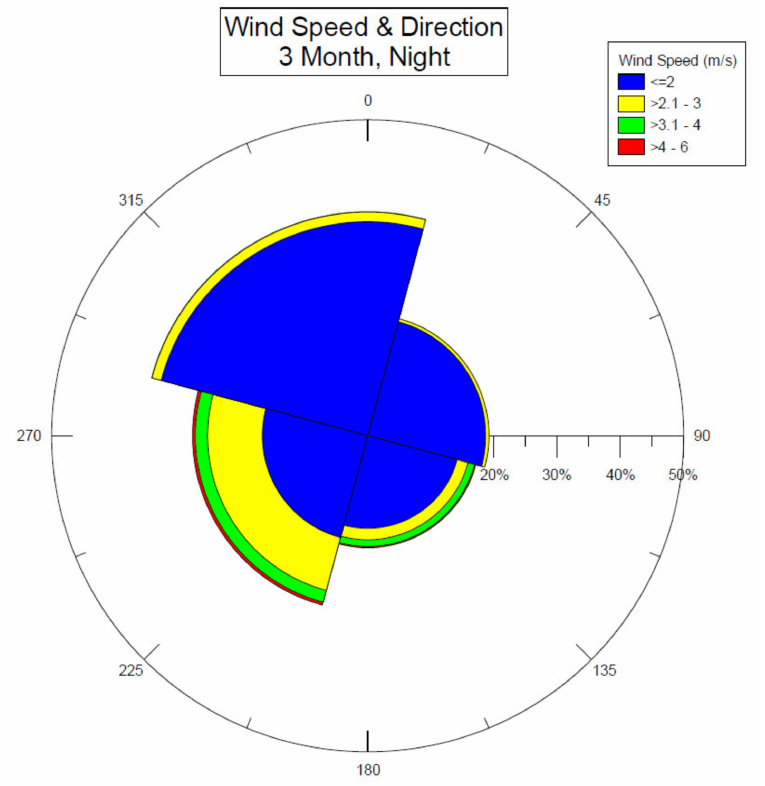
Figure 13. Waubra Wind Farm Nighttime Wind-Post Construction re Microphone Height measured wind data for wind direction